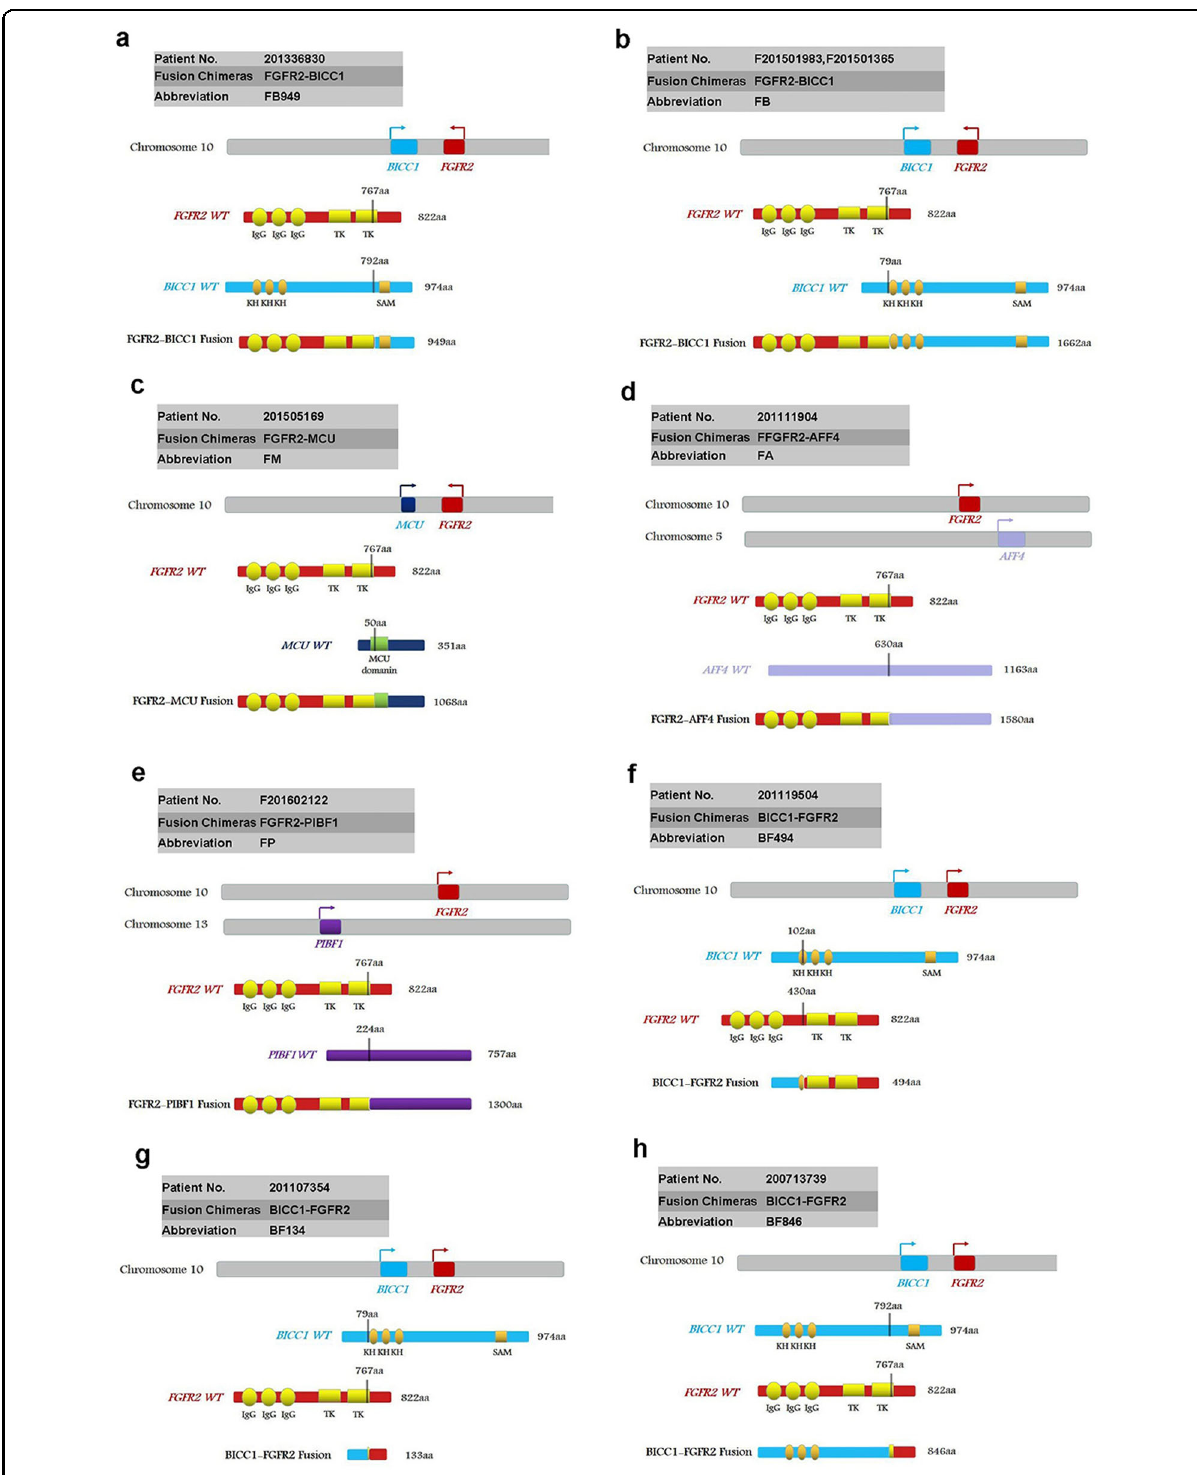
Fig. 3 Schematic representation of FGFR2 fusion proteins. Fusion proteins were described as FB949 ( a ), FB ( b ), FM ( c ), FA ( d ), FP ( e ), BF494 ( f ), BF134 ( g ), and BF846 ( h ). Ig immunoglobulin-like domain, TM transmembrane domain, kinase protein tyrosine kinase domain, CC coiled-coil domain, KH K homology RNA binding domain, SAM sterile alpha motif. The vertical lines indicate